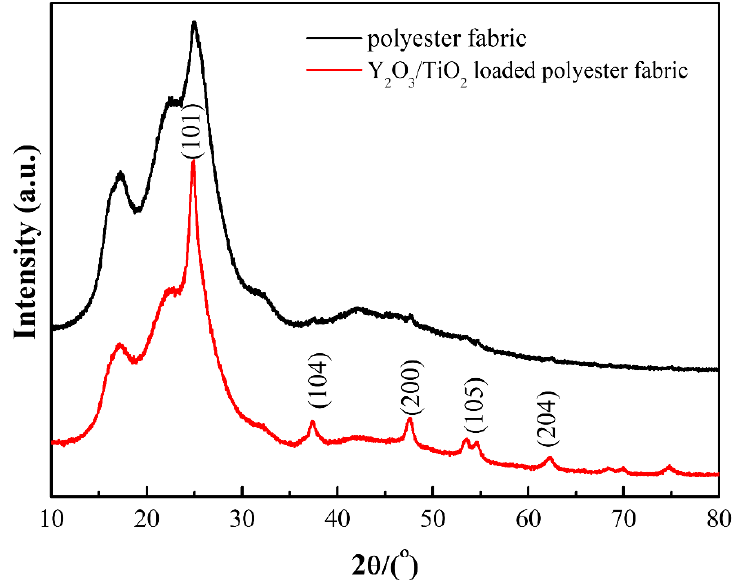
Figure 7. X-ray diffraction patterns of polyester fabric and Y 2 O 3 /TiO 2 -loaded polyester fabric.